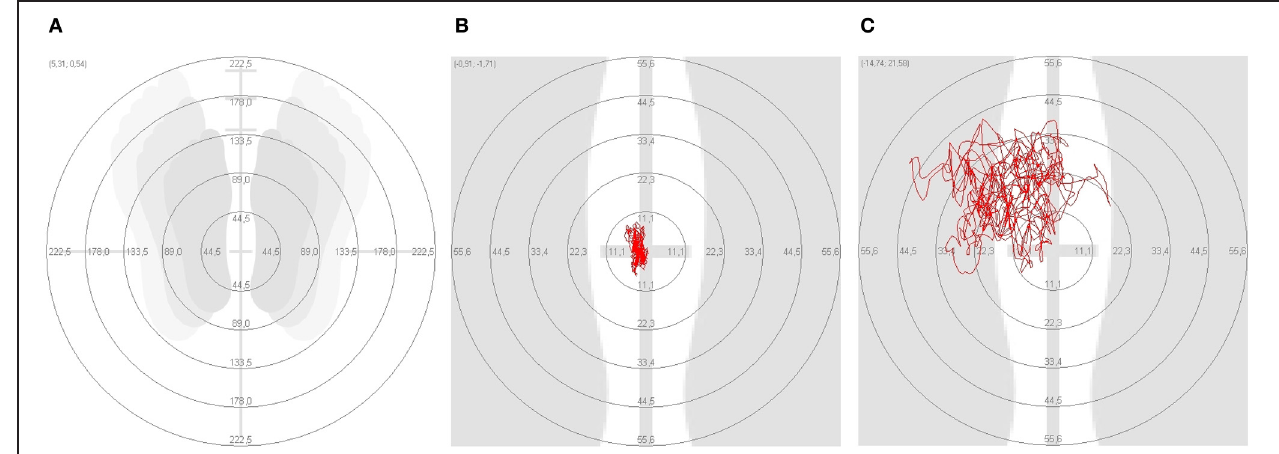
FIGURE 2 | On the platform test the different posturographic parameters were compared. (A) Standing position; (B) marked area in a healthy adult control (HAC); (C) marked area in a patient with Parkinson’s disease.